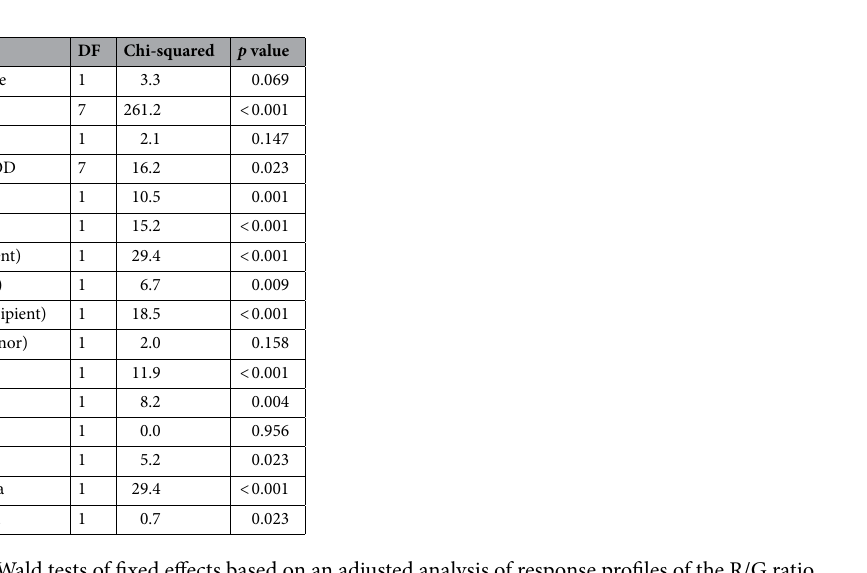
Table 2. Wald tests of fixed effects based on an adjusted analysis of response profiles of the R/G ratio level. CAD coronary artery disease, CRP C reactive protein, DF degrees of freedom, ECMO